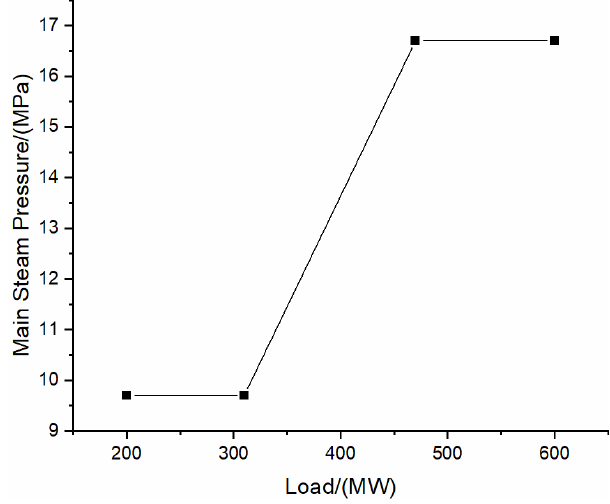
Figure 10. Operation mode of steam turbine unit. When the load is between 200 and 310 MW, constant pressure is used. As the load increases from 310 to 470 MW, sliding pressure should be adopted. After reaching 470 MW, constant pressure mode is suitable.